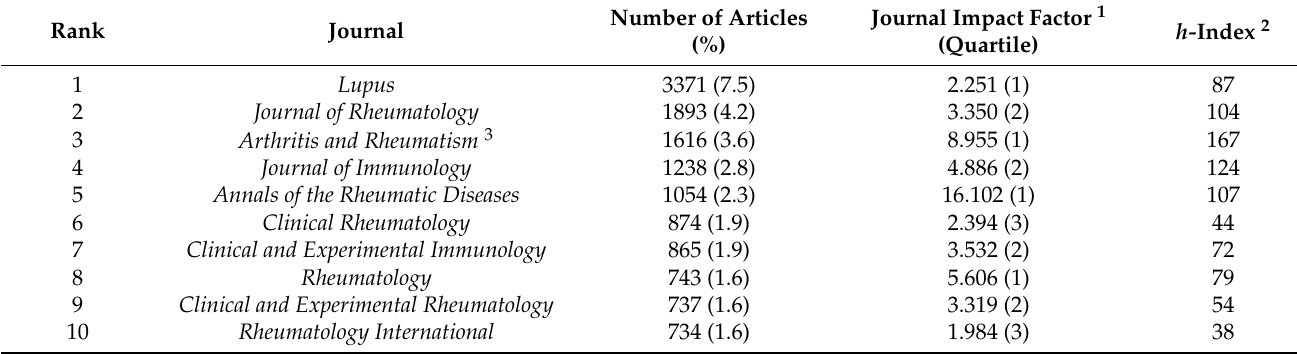
Table 3. The top 10 journals based on the number of original articles on systemic lupus erythematosus.